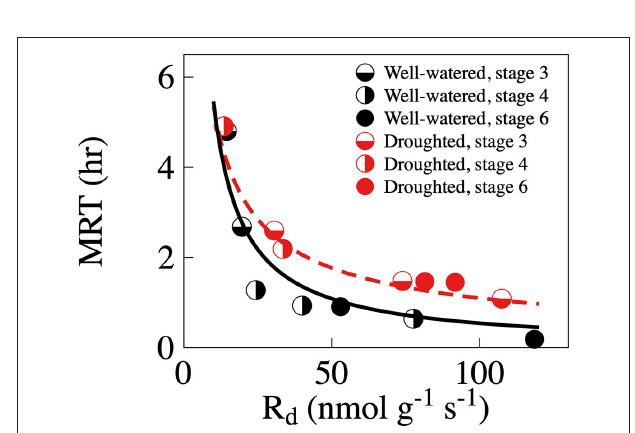
FIGURE 5 | Relationship between rates of mean residence time (MRT) of the 13 C label in respiratory CO 2 efflux and respiration (R d ) in well-watered (black symbols) and droughted (red symbols) trees. Regression lines between R d (x) and MRT (y) are y = 55.24 x − 1.01 , adj. R 2 = 0.971, p < 0.001, for the well-watered trees (full black line) and y = 25.94 x − 0.69 , adj. R 2 = 0.916, p < 0.001 (red broken line). One observation is a individual shoot from an individual tree at a specific 13 C pulse-labeling event. Please note that due to the destructive nature of the sampling, individual shoots was only studied once, so different shoots were studied at different 13 C pulse-labeling